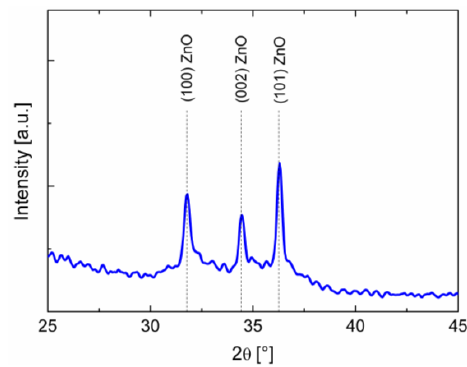
Figure 3. X-ray diffraction analysis of the sensing layer on the annealed sensor.